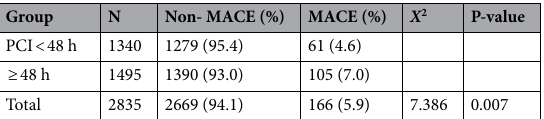
Table 5. Incidence of in-hospital MACEs between PCI < 48 h and ≥ 48 h.